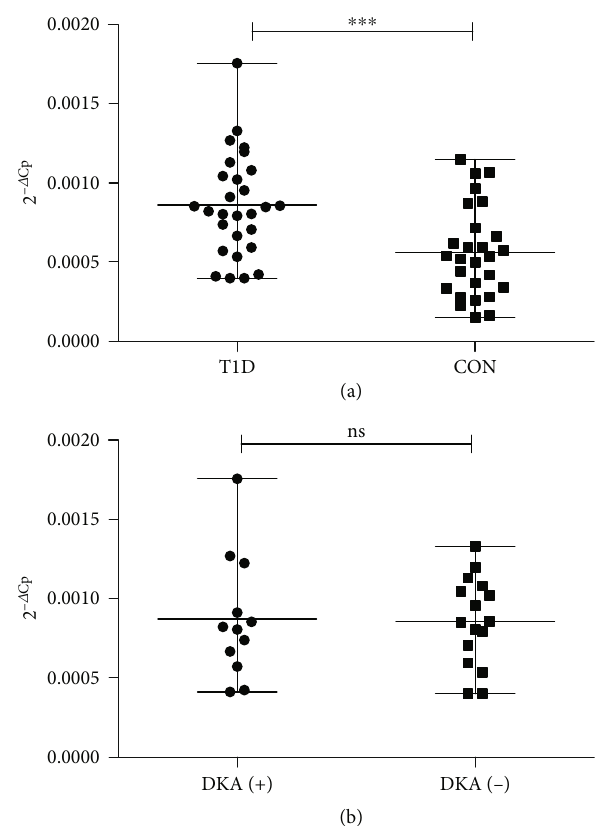
Figure 1: FOXO3 expression analysis in type 1 diabetes. (a) FOXO3 is overexpressed in the type 1 diabetes group compared to healthy controls ( ∗∗∗ P = 0 : 0005 , mean fold change 1.54). (b) Expression level of FOXO3 gene in the T1D group strati fi ed according to the presence of initial diabetic ketoacidosis (DKA). The patients with diabetic ketoacidosis did not present statistically signi fi cant di ff erences in FOXO3 expression compared to the patients without DKA ( P > 0 : 05 ). Horizontal lines indicate median with range; asterisks indicate signi fi cance, with P values estimated by unpaired t -test; T1D: type 1 diabetes patients; C: controls; DKA(+): cohort of patients with initial diabetic ketoacidosis; DKA(-): cohort of patients without initial diabetic